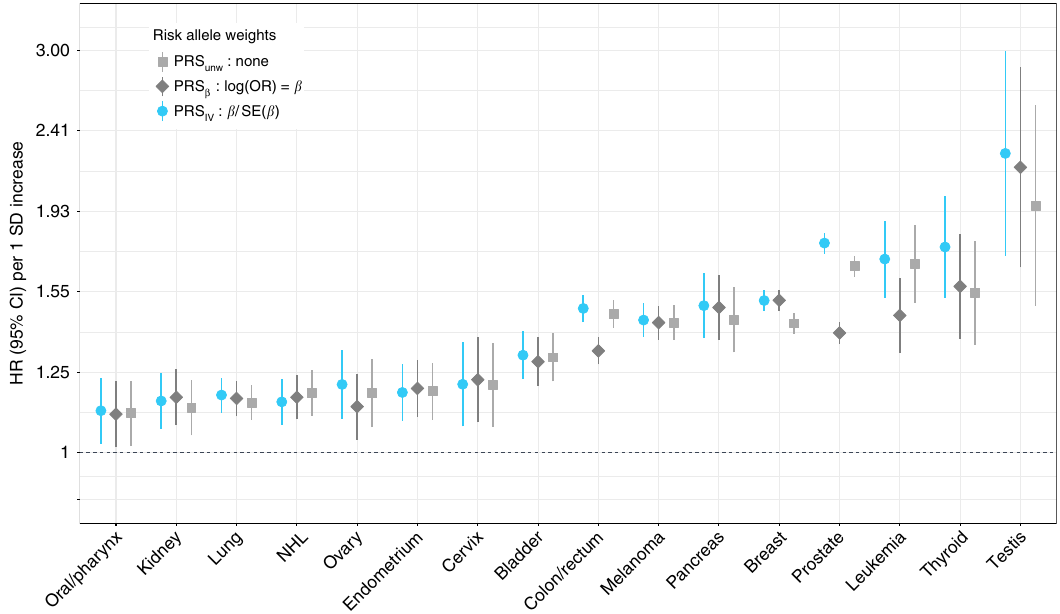
Fig. 1 Hazard ratios (HR) per one standard deviation (SD) increase in the standardized polygenic risk score (PRS). HR were estimated using cause- speci fi c Cox proportional hazards models, accounting for mortality as a competing risk. A comparison of three weighting approaches for combining individual risk variants in the PRS is presented: standard weights based on per-allele log odds ratios (PRS β ), unweighted sum of risk alleles (PRS unw ), and inverse variance (IV) weights (PRS IV ).